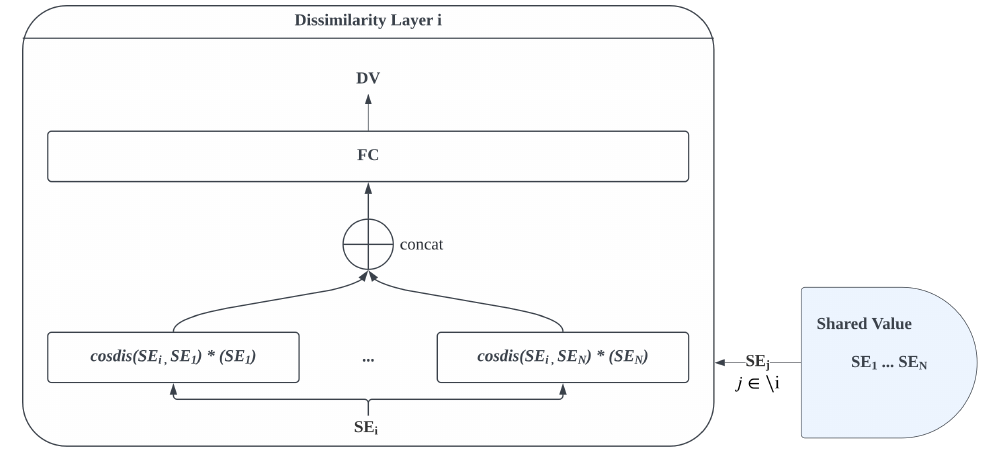
Figure 7. Dissimilarity layer in critic